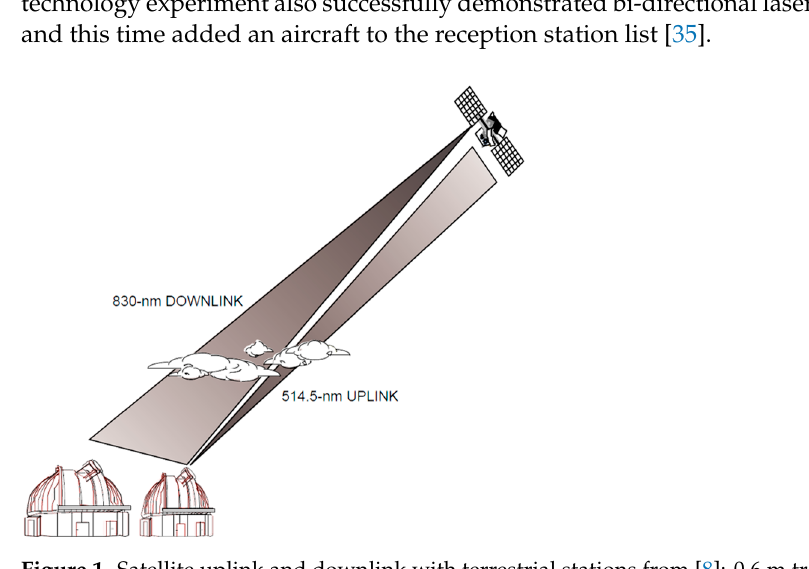
Figure 1. Satellite uplink and downlink with terrestrial stations from [8]: 0.6 m transmitter uplinking at 514.5 nanometers and 1.2 m receiver downlinking at 830 nanometers.